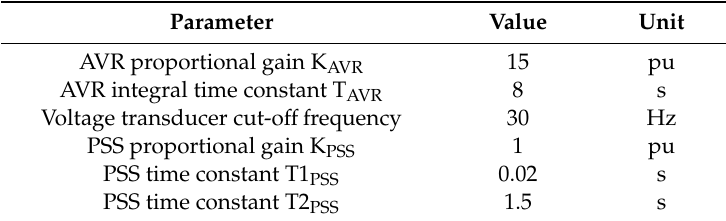
Table 3. TG units’ control system